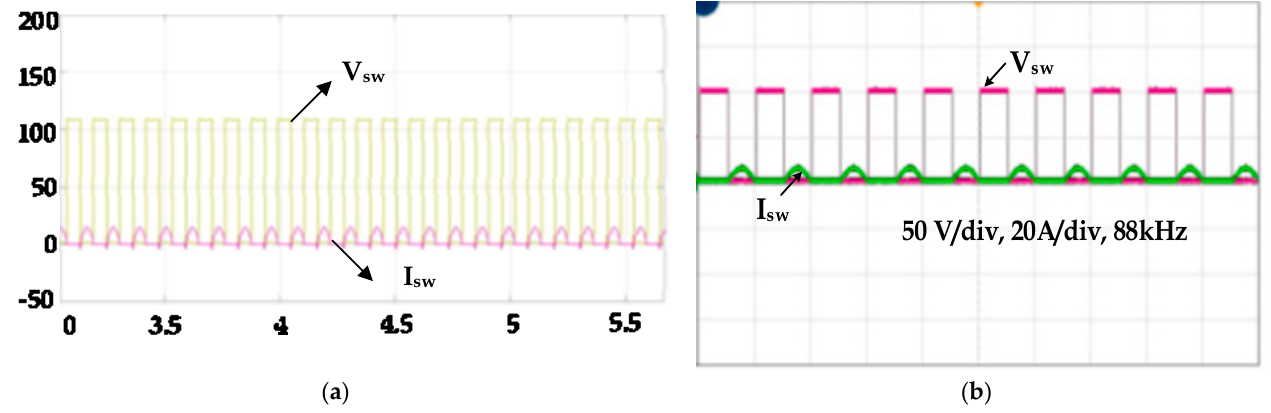
Figure 16. ( a ) Simulation and ( b ) experimental waveforms of switch voltage and current.